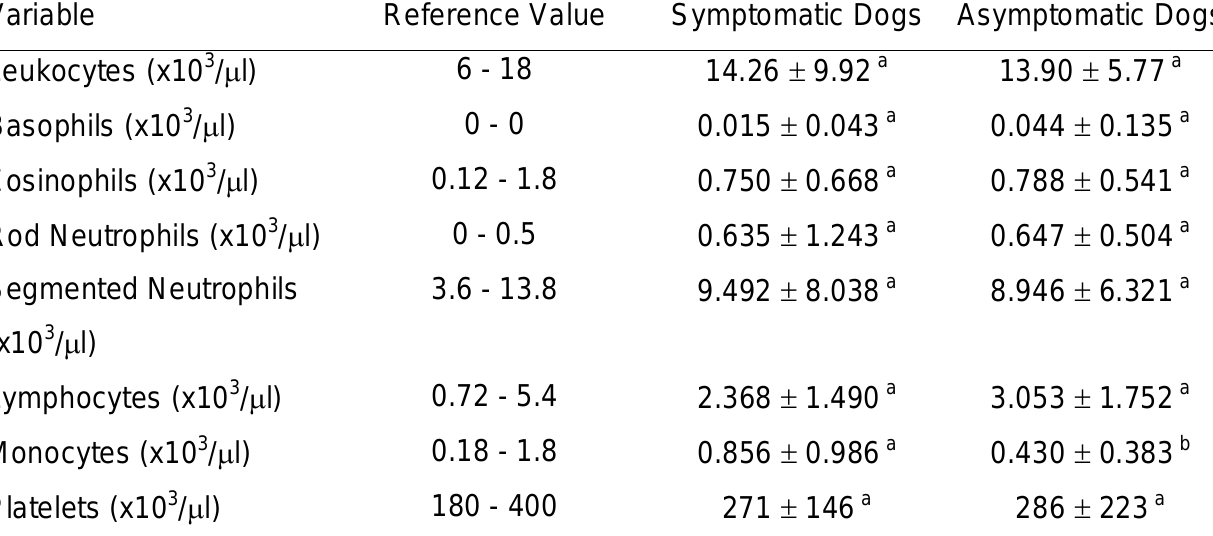
Table 2: Mean and standard deviations of leukometric variables for symptomatic (n=34) and asymptomatic (n=17) VL seropositive dogs from Teresina, Piauí State, Brazil, 2002.